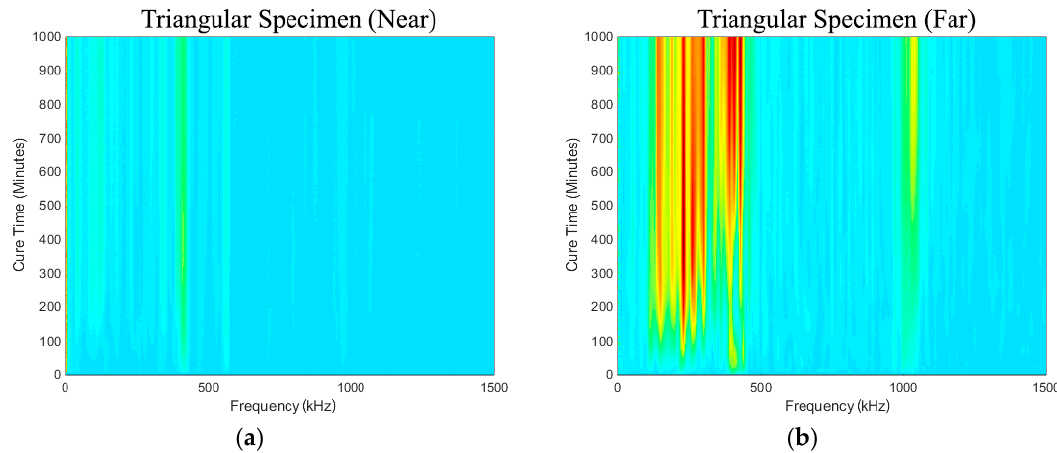
Figure 11. Triangular specimen ( a ) Near and ( b ) Far: Change in frequency spectrum for each cure time